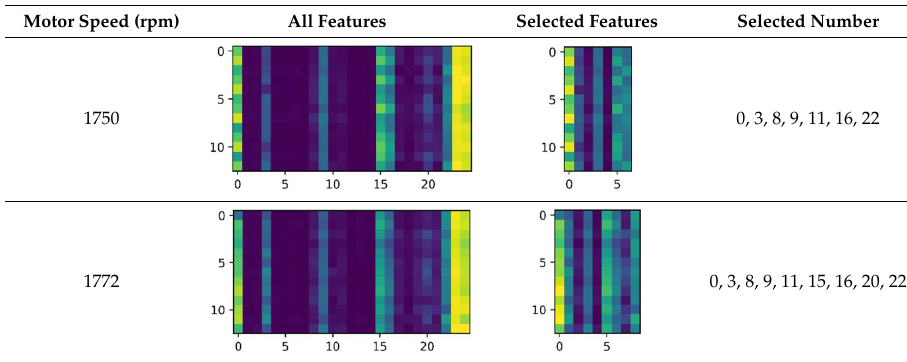
Table 3. CWRU dataset features selected by the proposed method. (The pictures are the visualization results for the corresponding speed samples. The horizontal axis in the figure represents the number of features, and the vertical axis represents the first 13 samples. For the sake of beauty, the first 13 samples are chosen).